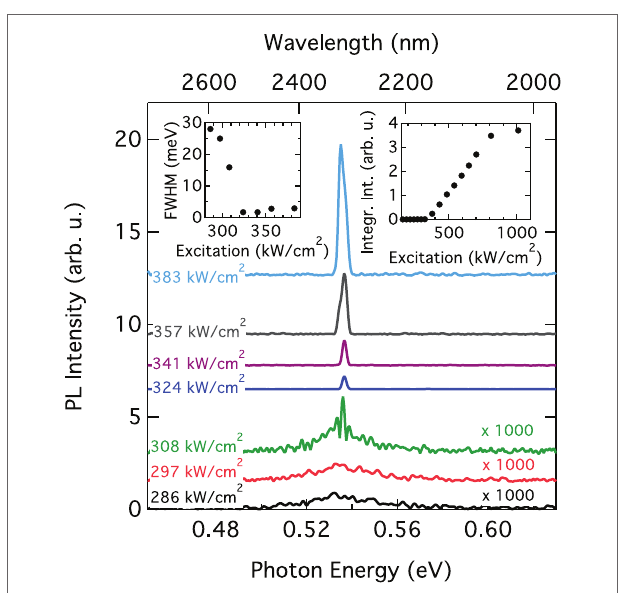
FiGURe 13 | Lasing emission spectra measured from the facet of a 5- μ m wide and 1 mm long FP waveguide cavity under optical pumping at 20 K . A clear threshold behavior can be observed in the spectra with respect to output intensity and linewidth, c.f. inset to the right and left hand side, respectively.